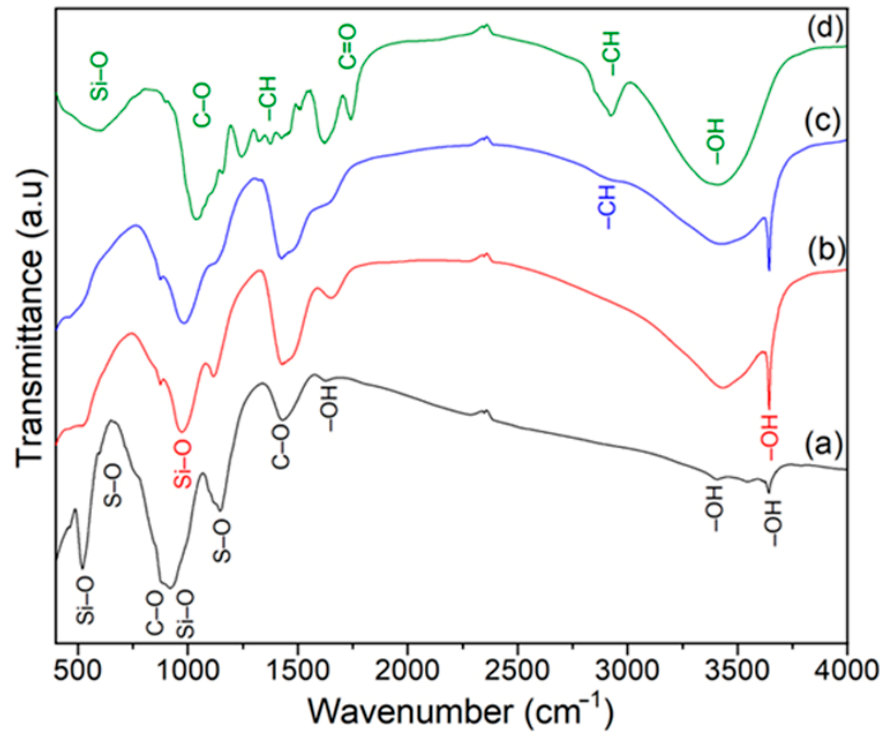
Figure 9. FT-IR spectra of ( a ) CEM, ( b ) CP, ( c ) CP10VSW, ( d ) VSW samples.